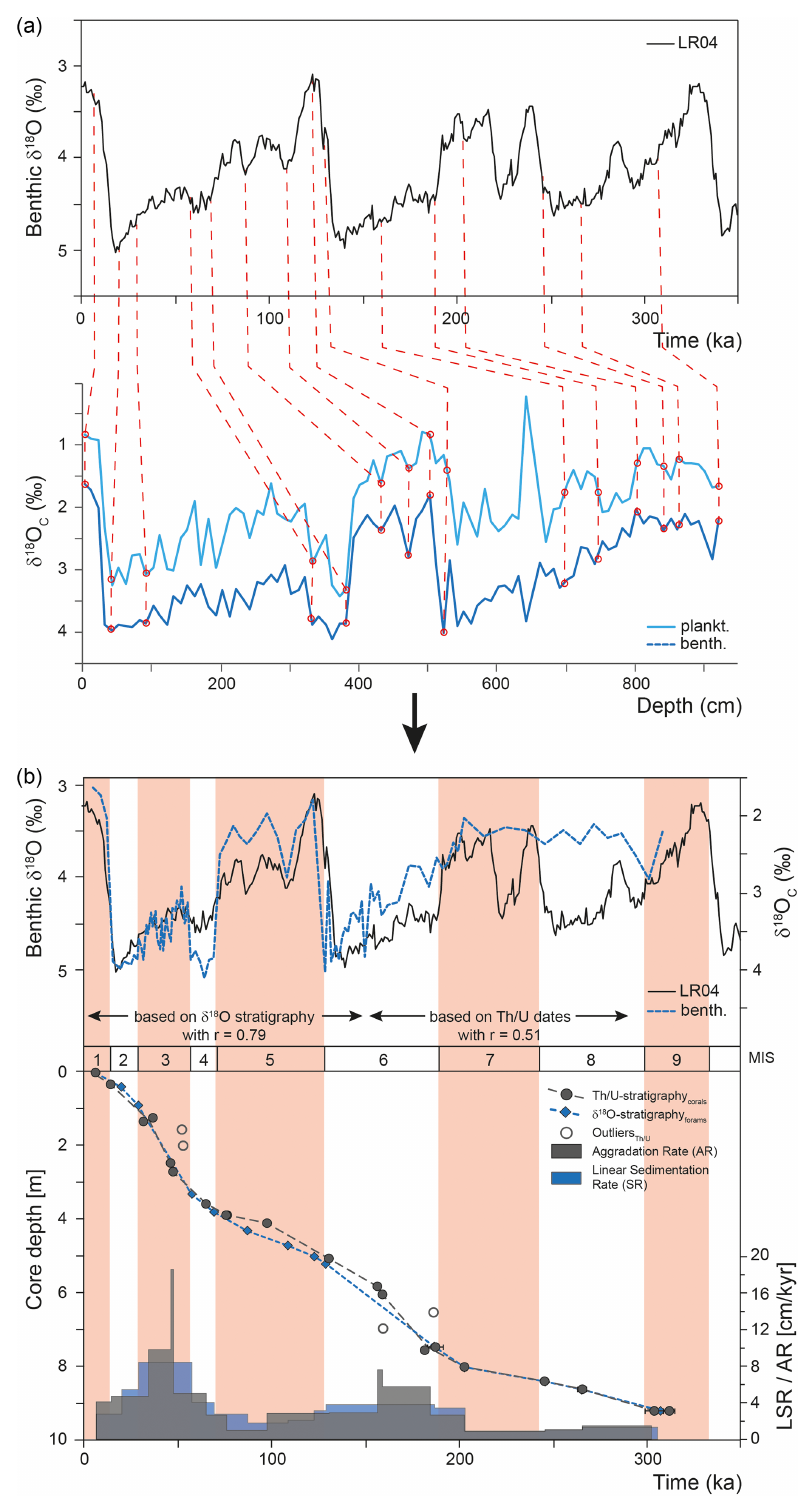
Figure 4. (a) Correlation pointers (see Table 3) between the LR04 benthic δ 18 O stack of Lisiecki and Raymo (2005) and the benthic ( L. lobatula ) and planktonic ( G. bulloides ) δ 18 O record of MD13-3462G. (b) The δ 18 O stratigraphy has good correlation for the younger part (0–150ka, r = 0 . 79, p< 0 . 001), but the lower part ( > 150ka), which is based on the U-series CWC dates, has a weak correlation ( r = 0 . 51, p< 0 . 009). The comparison between the U-series- and δ 18 O-stratigraphy-based age–depth correlations indicates good coherence. The resulting δ 18 O-stratigraphy-based linear sedimentation rate (LSR) may serve as an indication for changes in the sedimentary regime but shows similar values and/or trends as the CWC-age-based aggradation rate (AR), with higher rates during MIS 3, MIS 6, and late MIS 7. Marine Isotope Stages (MISs) follow boundaries defined by the LR04 stack (Lisiecki and Raymo, 2005). https://doi.org/10.5194/cp-18-1915-2022 Clim. Past, 18, 1915–1945,